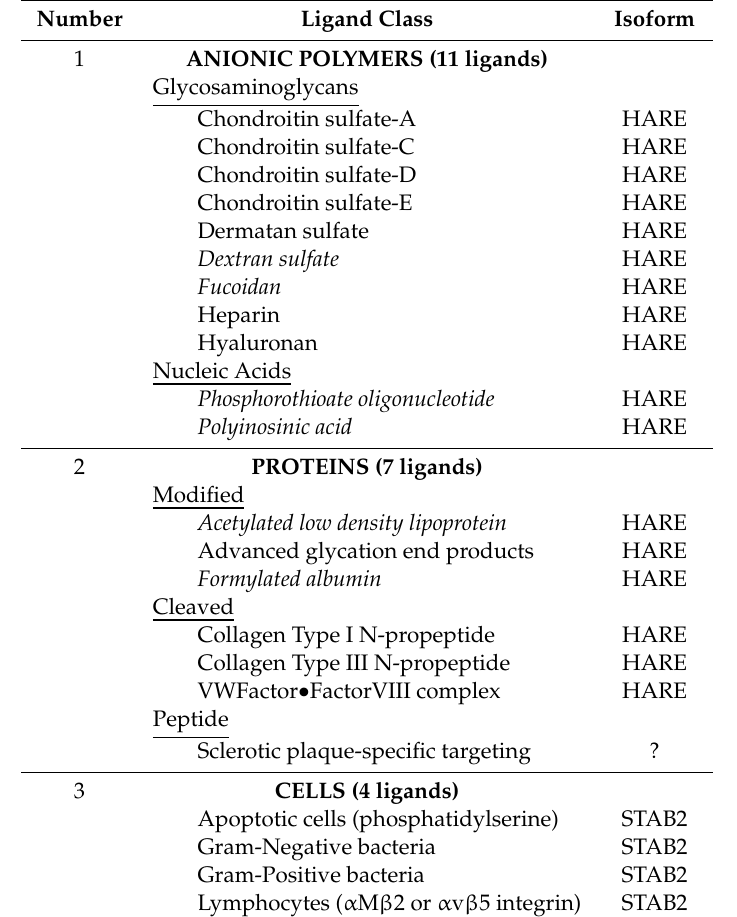
Table 2. HARE and Stabilin-2